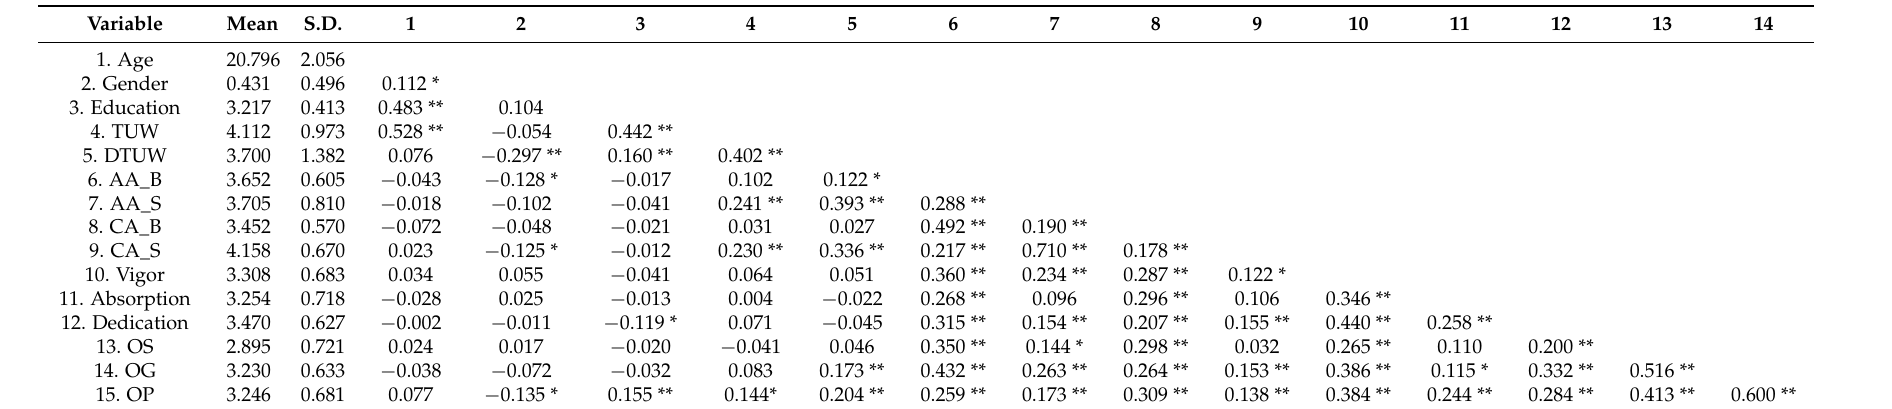
Table 8. Means, standard deviations, and correlations of the research